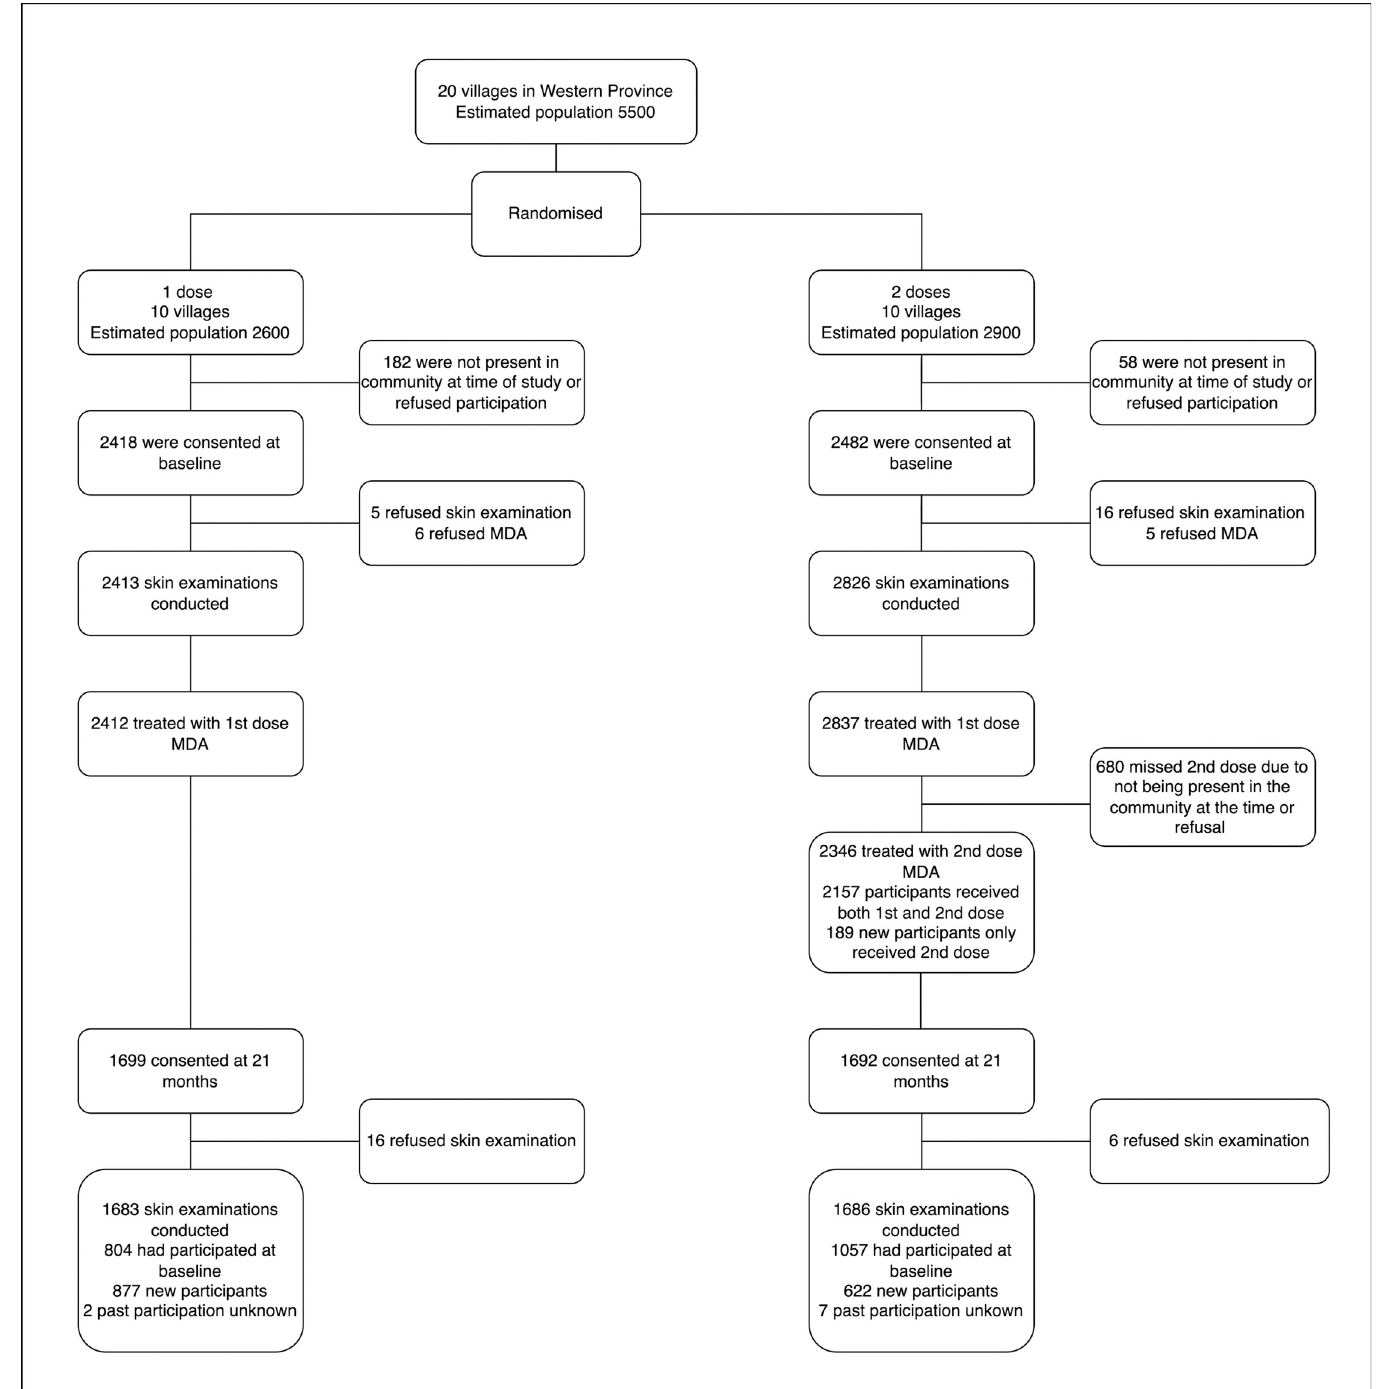
Fig 2. CONSORT flow diagram detailing participation in study. MDA: Mass Drug Administration.